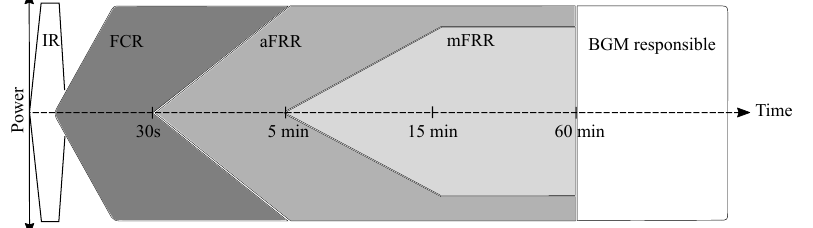
Figure 4. Activation of the different types of control energy (IR = Instantaneous reserve, BGM = Balancing group